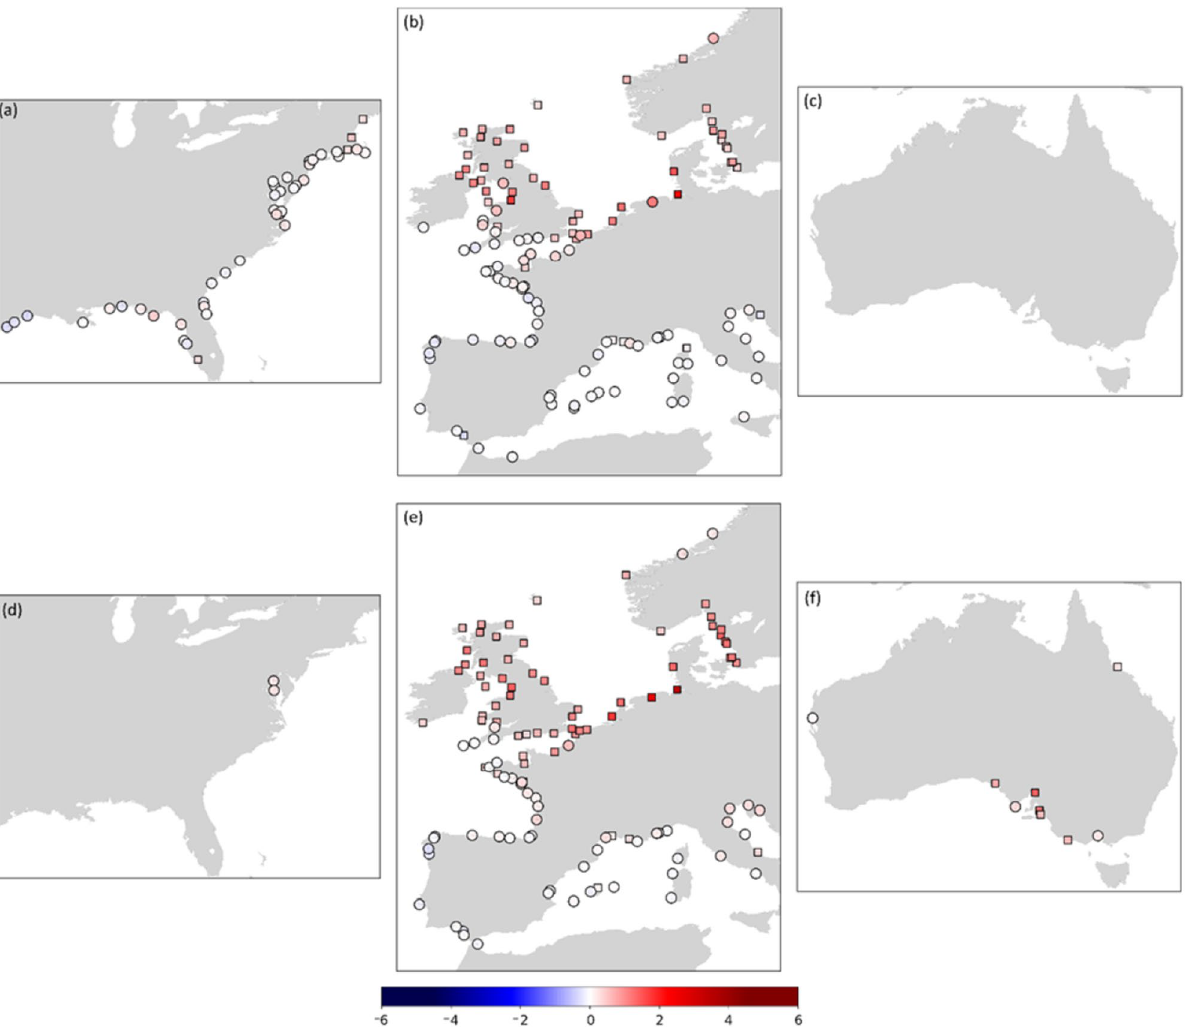
Figure 7. Trends (mm/year) for the 99th percentile surges for G-20CR ( a – c ) and G-E20C ( d – f ) corresponding to 1930–2015 and 1930–2010 respectively. Rectangle markers indicate significant trends at the 5% significance level. Rossum, Guido van, et al., The Python Language Reference, Python Software Foundation; http:// docs. python. org/ py3k/ refer ence/ index.